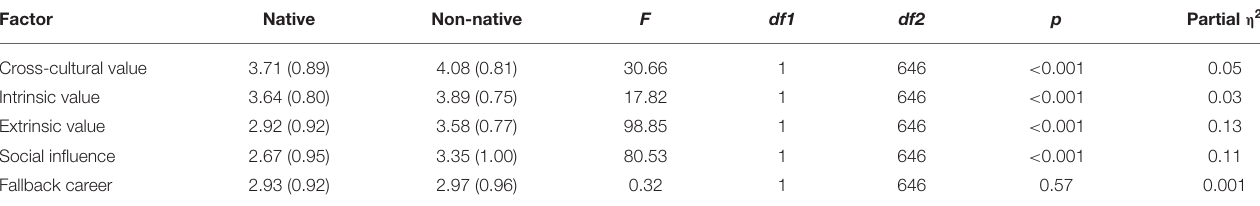
TABLE 7 | Summary of the MANOVA test. Factor